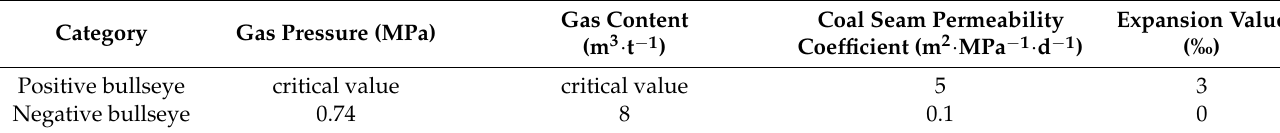
Table 2. Positive and negative bullseye